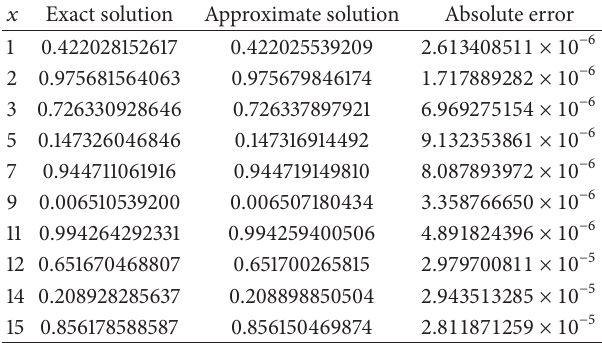
Table 1: Numerical results for Example